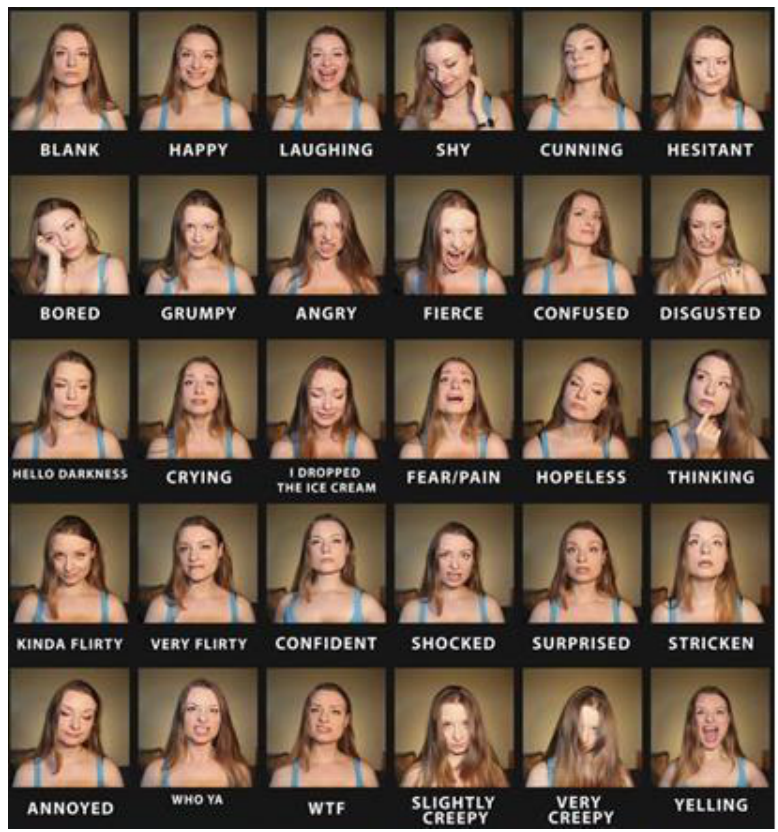
Figure 38. Facial emotion images. Table 4. Comparative summary of some accessible 3D face recognition